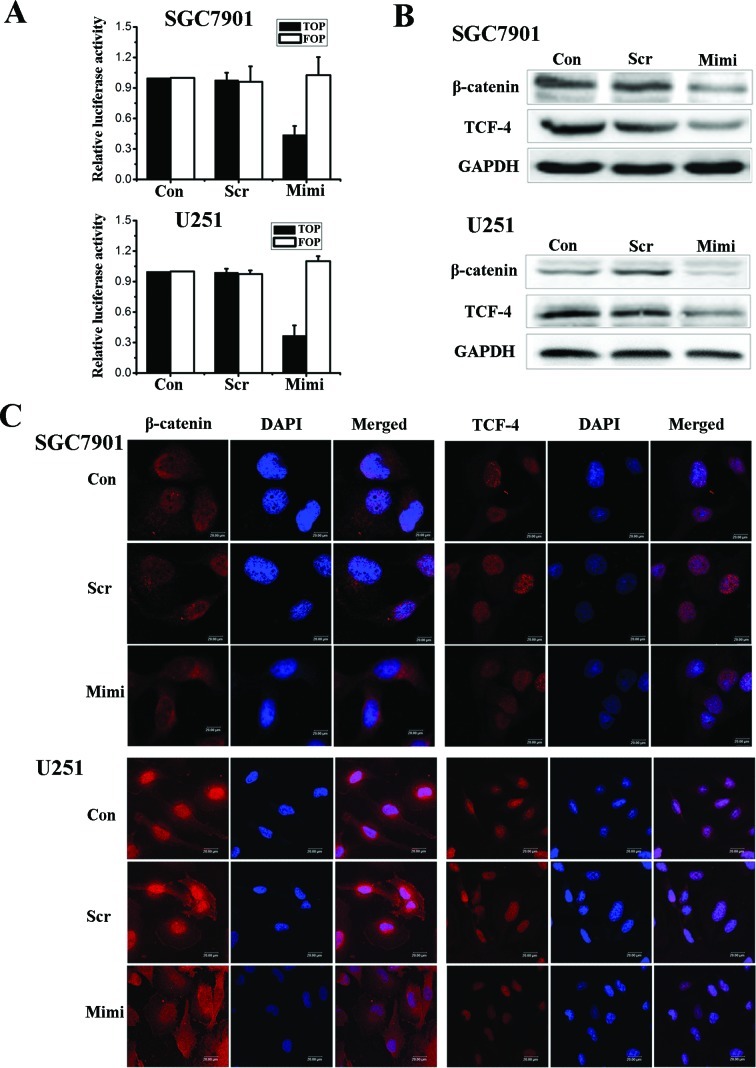
Effect of miR-200a on the activity the Wnt/β-catenin signaling pathway. (A) The luciferase reporter assay using TopFlash and FopFlash vectors was utilized to study β-catenin TCF/LEF promoter activity. The TopFlash reporter vector has 6-TCF binding sites, while FopFlash has mutated TCF binding sites. SGC7901 and U251 cells were co-transfected with different expression vectors as indicated. MiR-200a mimic treatment decreased β-catenin TCF/LEF promoter activity. (B) Up-regulation of miR-200a decreased β-catenin and TCF-4 expression. (C) Immunofluorescence assay for β-catenin indicates that the location of β-catenin in cells shifts from nuclear to cytoplasmic when the expression of miR-200a was increased, and that TCF-4 expression decreased in the nucleus compared to control vector.